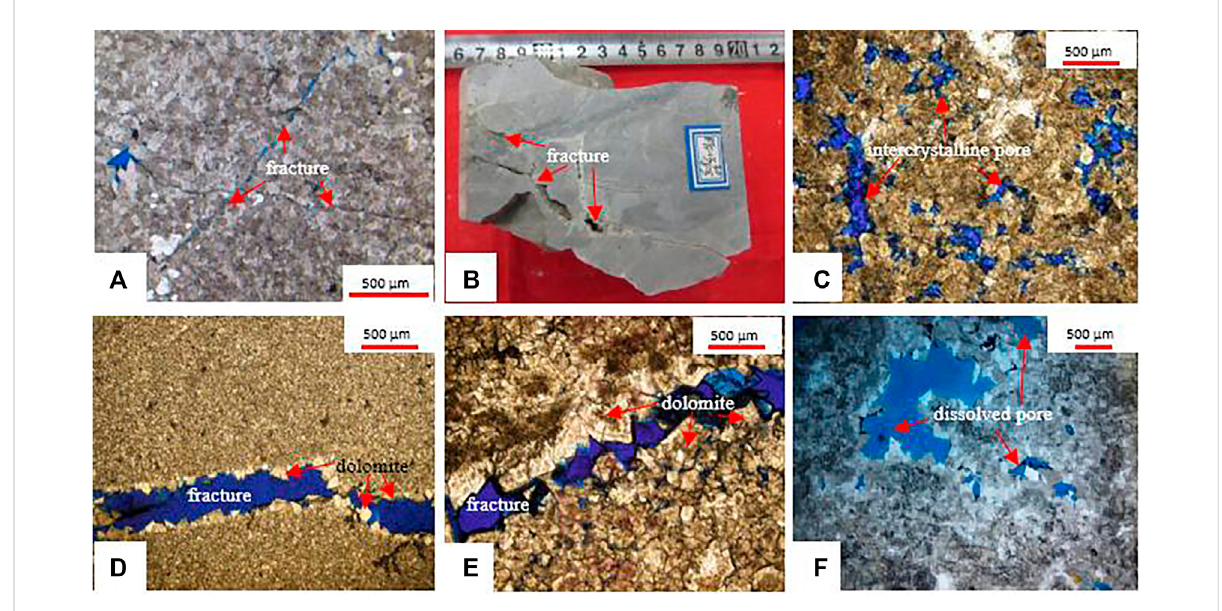
FIGURE 7 Characteristics of dissolution pores in Cambrian reservoirs. (A) medium-crystalline dolomite, BT5, ∈ 3 , 4,812.9 m, cross-polarized light, ×50 (B) – 4,811.10 m; (C) residual fi ne-crystalline dolarenite, BT5, ∈ fi ne-crystalline dolomite, BT5, ∈ 3 , 4,811.01 fracture fi lled with allochthonous dolomite, XH2, ∈ 3 5,595.761 m, blue thin sections, plane polarized light, ×50; (E) fi ne-crystalline dolostone, YQ6,